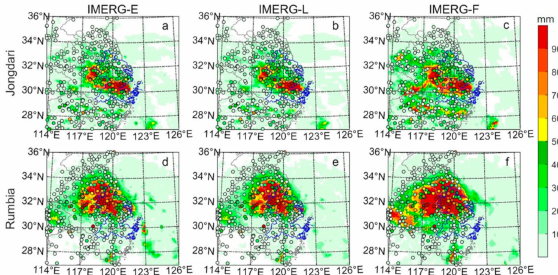
Figure 2. Spatial distribution of accumulated precipitation from IMERG: ( a – c ) for TC Jondari during 0600 UTC 02 to 1800 UTC 03 August 2018; ( d – f ) for TC Rumbia during 0400 UTC to 1400 UTC 17 August 2018. Each dot represents an observed accumulation precipitation during TC landfalling.